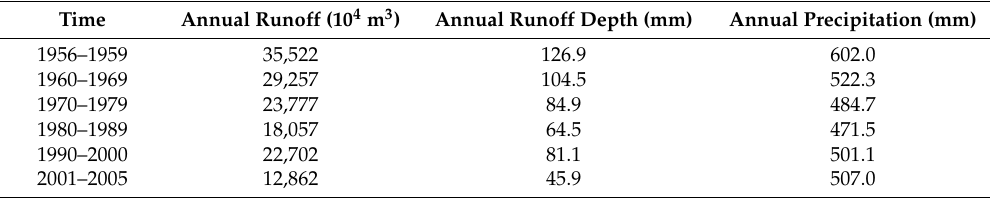
Table 4. Annual precipitation and runoff at the Jingle hydrologic